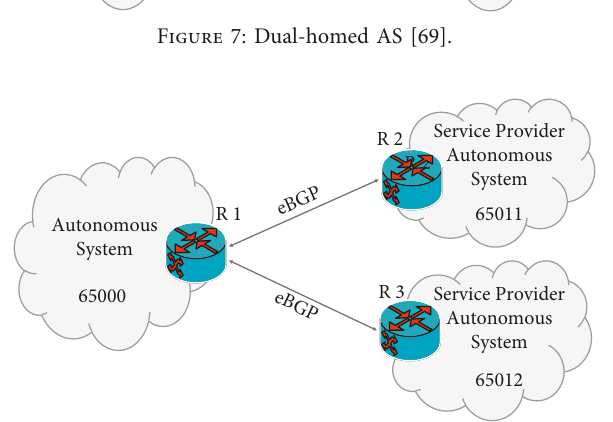
Figure 8: Multihomed AS [69].